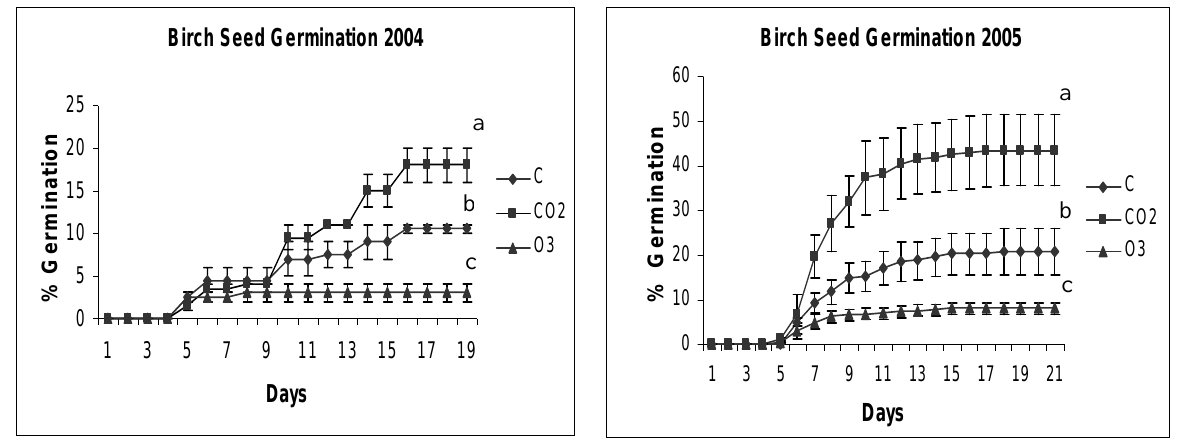
FIGURE 2. Germination of birch seed from trees exposed to background or elevated CO 2 and O 3 ; seeds from 2004 growing season (left), seeds from 2005 growing season (right). Letters a, b, and c denote significant differences in treatments at alpha level of